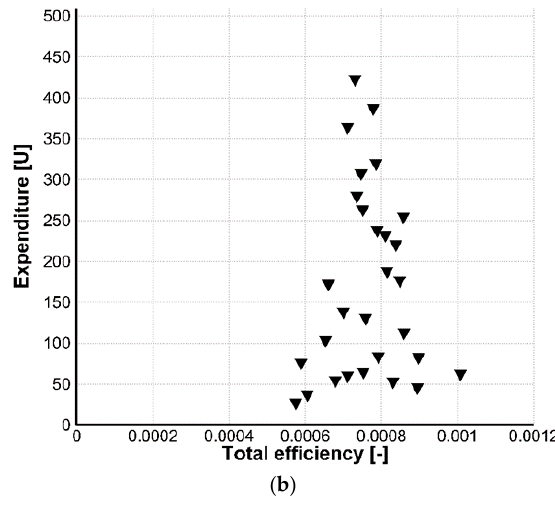
Figure 3. ( a ) Tradeoff between the power output and total efficiency for the Kerman SCPP; and ( b ) tradeoff between the total efficiency and the expenditure for the Kerman SCPP.